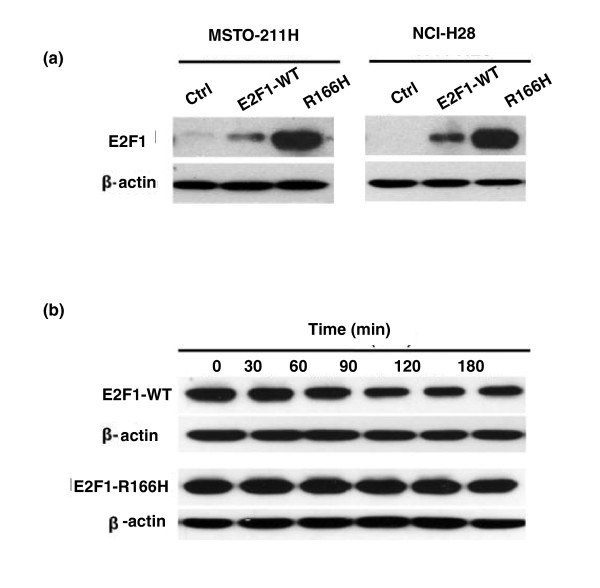
Accumulation of mutant E2F1 protein in cells due to increased stability of E2F1-R166H. (a) E2F1 protein levels detected by anti-E2F1 antibody (KH95) 48 hours after transfection. WT, wild type. (b) Degradation assay performed in MSTO-211H cells over-expressing E2F1 treated with 25 μg/ml cycloheximide. Levels of E2F1 protein were monitored every 30 minutes for 3 hours using anti-E2F1 antibody.